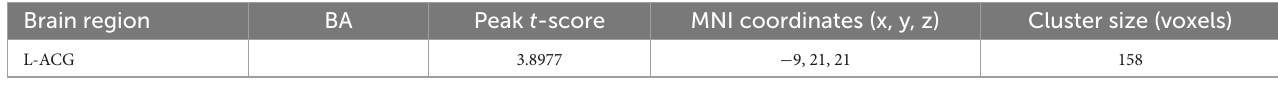
TABLE 4 Significant differences in sFC values of the right V1 between HM patients and HCs.